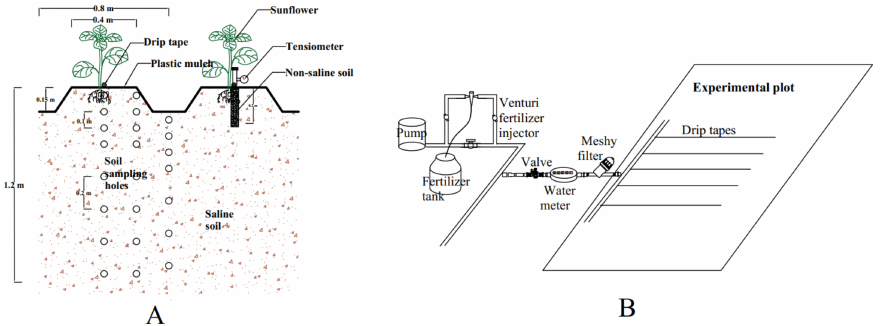
Figure 1. Schematic of the experimental design. ( A ) fertigation system in the experiment and ( B ) ridge planting pattern under drip